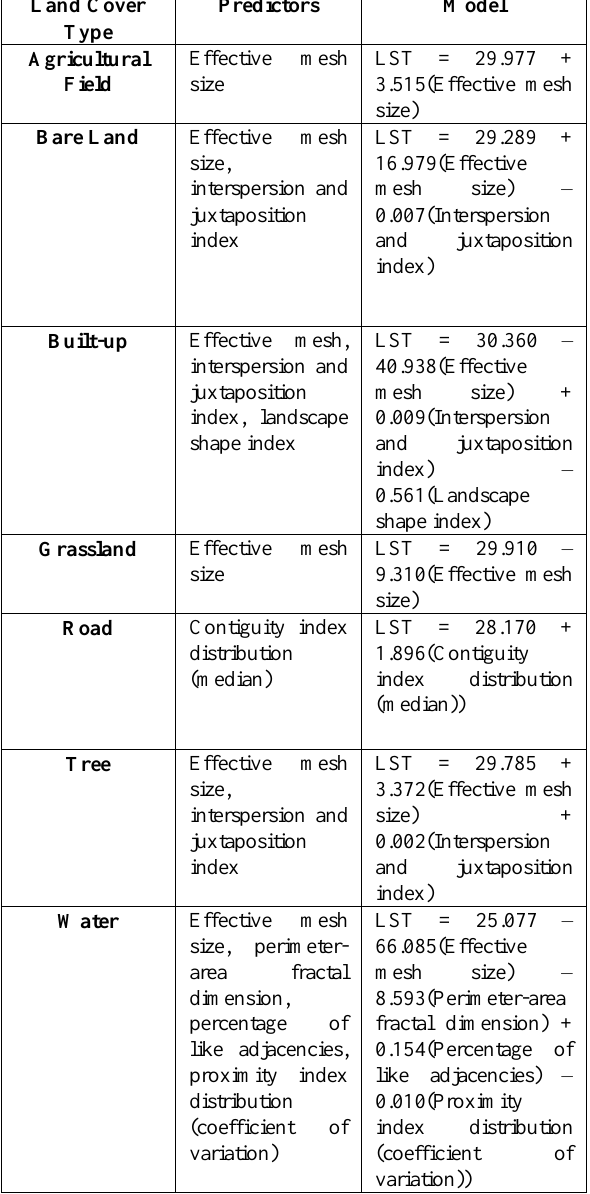
Table 5. Summary of all classes with their top predictors and linear models for